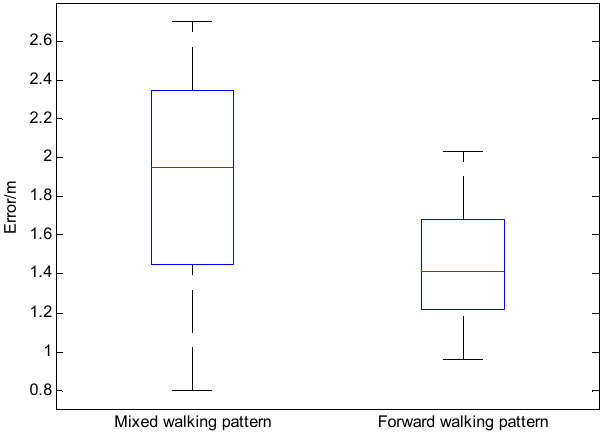
Figure 9. Positioning error of mixed-pattern and forward-pattern.